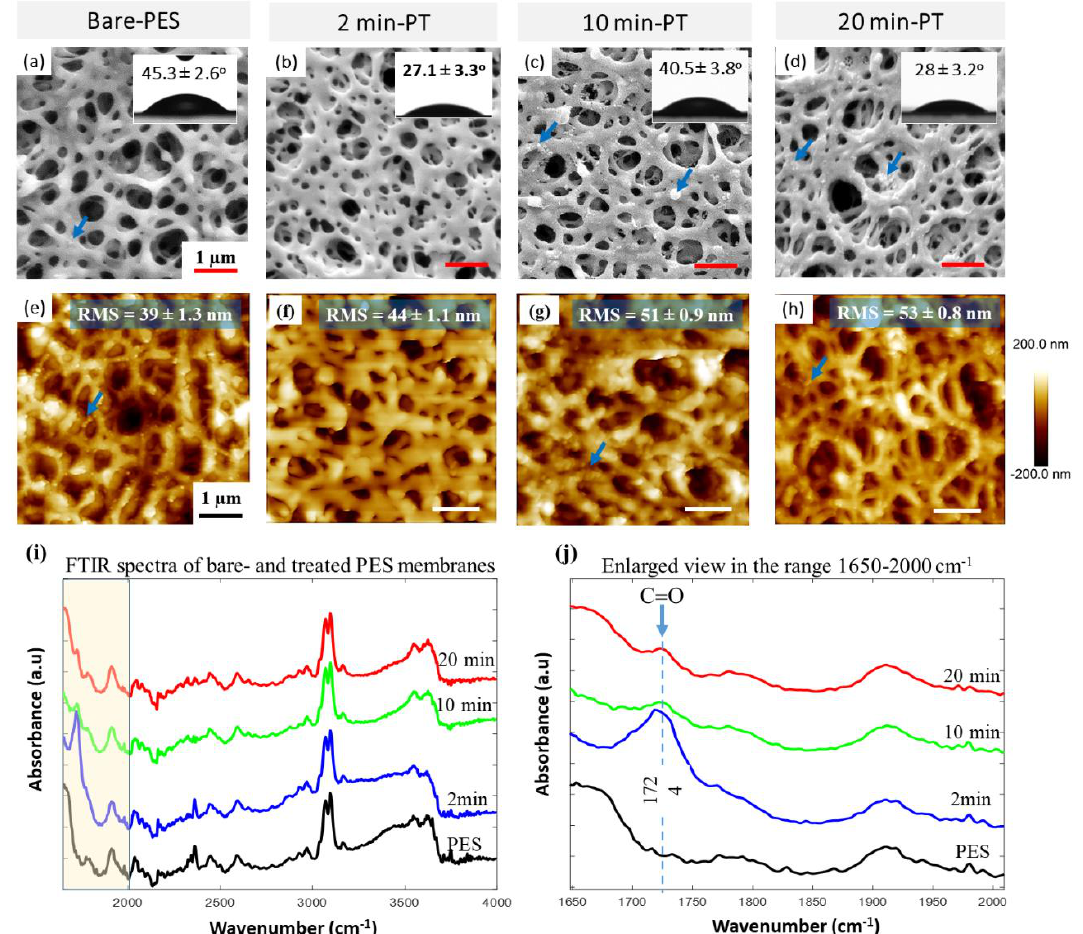
Figure 2. Morphology and characteristics of the bare and treated PES membrane surfaces obtained at various PT exposure times (2, 10, and 20 min). ( a – d ) SEM, ( e – h ) AFM, ( i ) FTIR-ATR, ( j ) enlarged view of the collected FTIR-ATR spectra shown in panel (i) for the range 1650 to 2000 cm − 1 . The water contact angle (WCA) measurements are indicated in the insets of panels a–d and the surface roughness (RMS) in the insets of panels e–h.